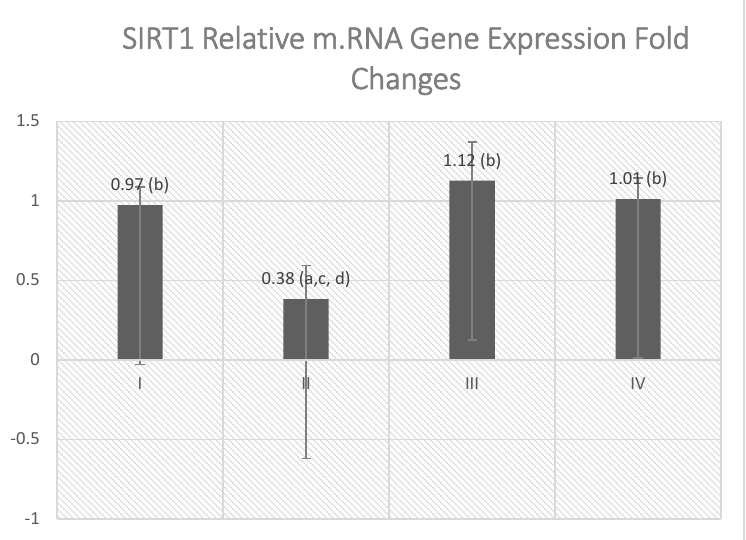
Figure 7. Effect of empagliflozin treatment on SIRT1 gene expression. Values are represented as mean ± SD (n = 10). a denotes a statistically significant difference compared to group I; b denotes a statistically significant difference compared to group II; c denotes a statistically significant difference compared to group III; d denotes a statistically significant difference compared to group IV, by one-way analysis of variance followed by post hoc Tukey’s test.